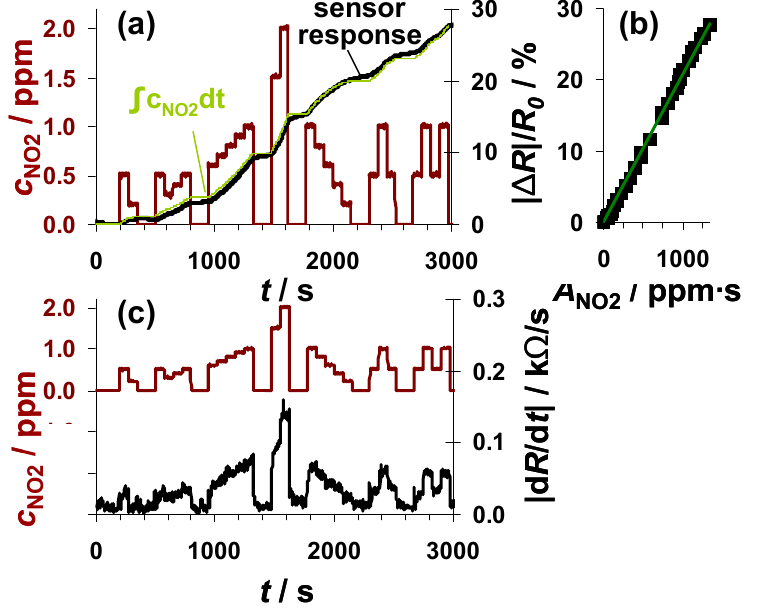
from 0.2 to 2 ppm in steps of 75 s 2